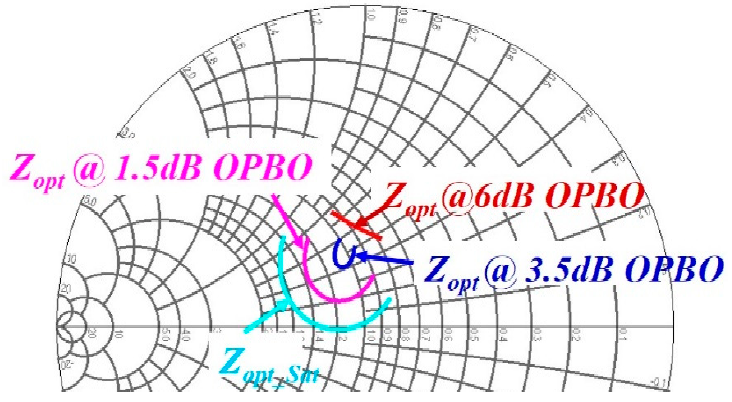
Figure 10. Simulated response of the Main Amplifier portion of the output combiner.